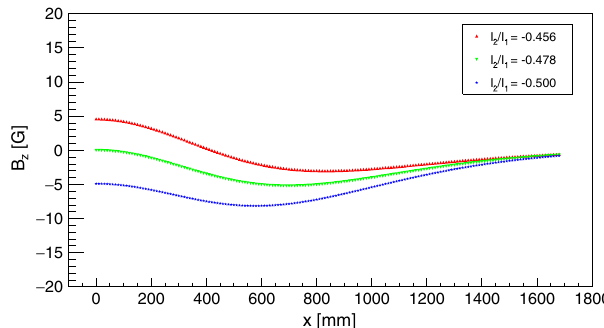
FIG. 15. Model 2: stray field B z along the EM-S beam section for the dual-layer solenoid with different current